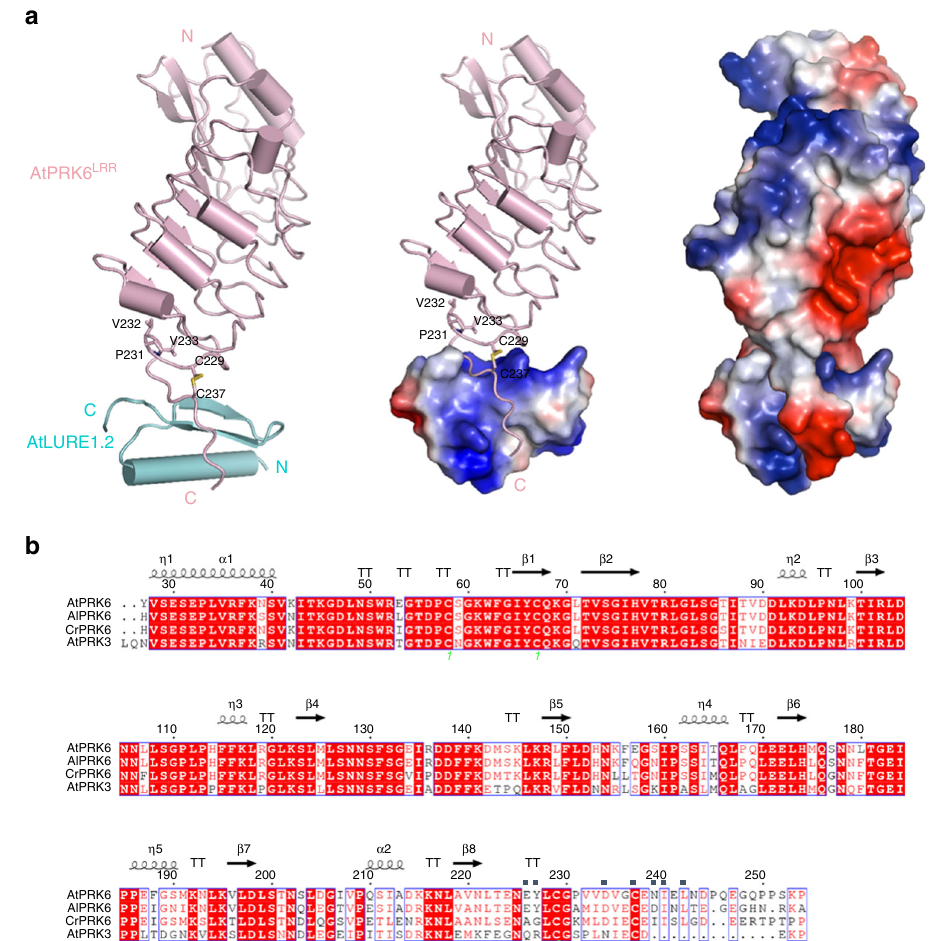
Fig. 2 Overall structure of the AtPRK6 LRR -AtLURE1.2 complex. a Structure of the AtPRK6 LRR -AtLURE1.2 complex shown in different modes. Left: both AtPRK6 LRR (pink) and AtLURE1.2 (cyan) are shown in cartoon. The disul fi de bond Cys229 − Cys237 is shown in yellow and three residues capping the hydrophobic core of the last LRR of AtPRK6 LRR are shown in stick and labeled. ‘ N ’ and ‘ C ’ represent N- and C-terminus, respectively. Middle: the C-terminal loop of AtPRK6 LRR binds a positively charged surface of AtLURE1.2. AtLURE1.2 is shown in electrostatic surface. Red, blue, and white represent negative, positive, and neutral surfaces, respectively. Right: interaction between AtLURE1.2 and AtPRK6 LRR is both shape-complementary and charge- complementary. Both AtLURE1.2 and AtPRK6 LRR are shown in electrostatic surface. b Sequence alignment of AtPRK6 LRR , AlPRK6 LRR , CrPRK6 LRR , and AtPRK3 LRR . Conserved and similar residues are boxed with red ground and red font, respectively. Two cysteine residues forming a disul fi de bond are indicated by the same green numbers. The AtLURE1.2-interacting amino acids of AtPRK6 LRR are highlighted with blue squares on